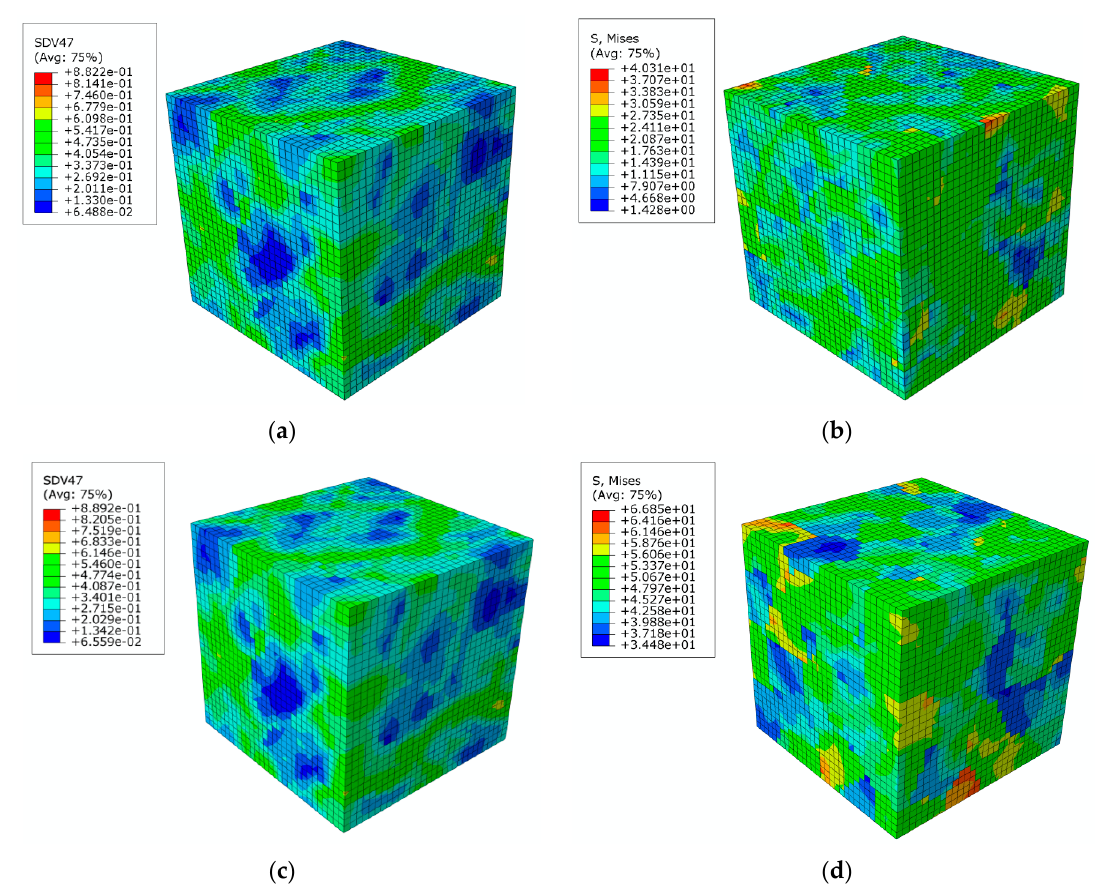
Figure 13. The accumulated equivalent plastic strain and Mises stress contours of a 3D Voronoi polycrystalline aggregate with offset strain of 20 μ m and 1000 μ m along 180° reloading path at polycrystalline aggregate with o ff set strain of 20 µ m and 1000 µ m along 180 ◦ reloading path at unloading point D-O D after 30 tension-compression cycles: ( a) equivalent plasticity strain contour unloading point D-O D after 30 tension-compression cycles: ( a ) equivalent plasticity strain contour with 20 u ε offset strain; ( b ) Mises stress contour with 20 u ε offset strain; ( c ) equivalent plasticity with 20 µε o ff set strain; ( b ) Mises stress contour with 20 µε o ff set strain; ( c ) equivalent plasticity strain strain contour with 1000 u ε offset strain; ( d ) Mises stress contour with 100 u ε offset strain. contour with 1000 µε o ff set strain; ( d ) Mises stress contour with 100 µε o ff set